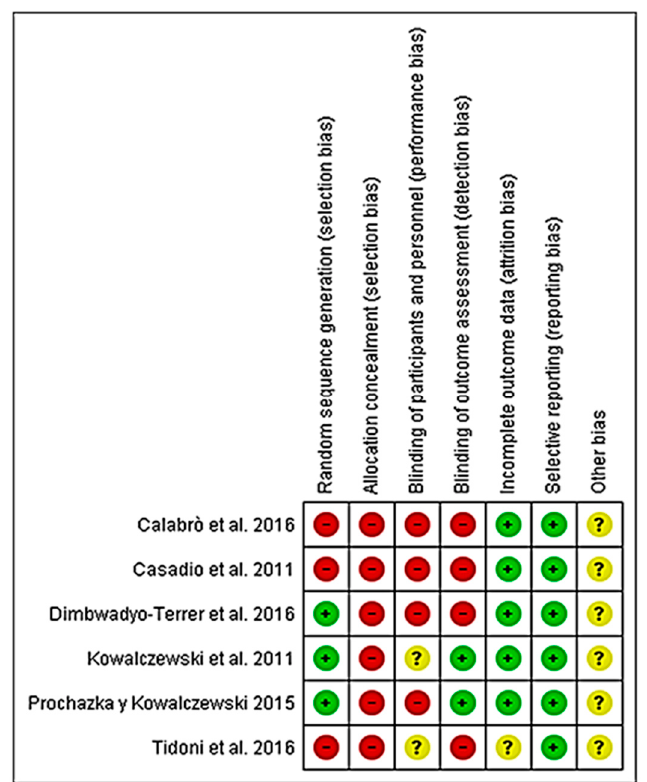
Figure 2. Risk of bias of the studies included in the systematic review [40–45].